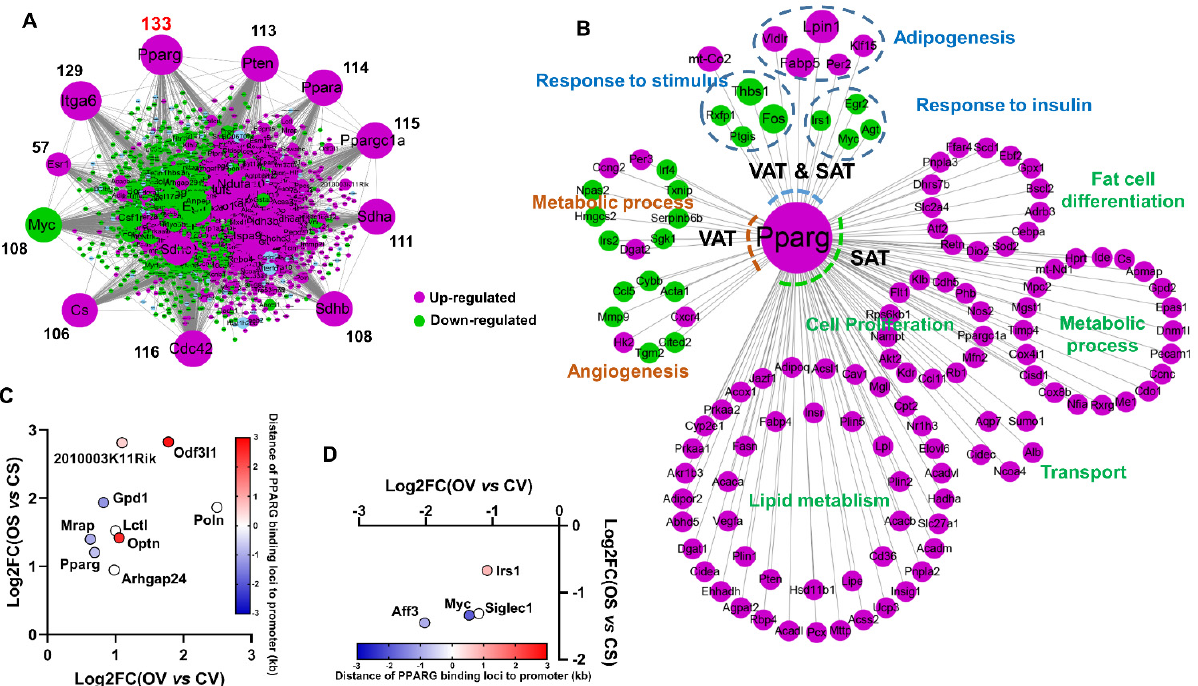
Figure 3. Integrated analysis reveals Pparg as a key mediator of the AT expansion in OVX female mice. ( A ) Protein-protein interaction (PPI) analysis of all DEGs induced by OVX in both VAT and SAT. ( B ) Subnetwork of DEGs centered on Pparg . Functional enrichment analysis of DEGs was conducted by DAVID (2021 updated). ( C ) OVX upregulated putative Pparg target genes in both SAT and VAT. ( D ) OVX downregulated putative Pparg target genes in both SAT and VAT.